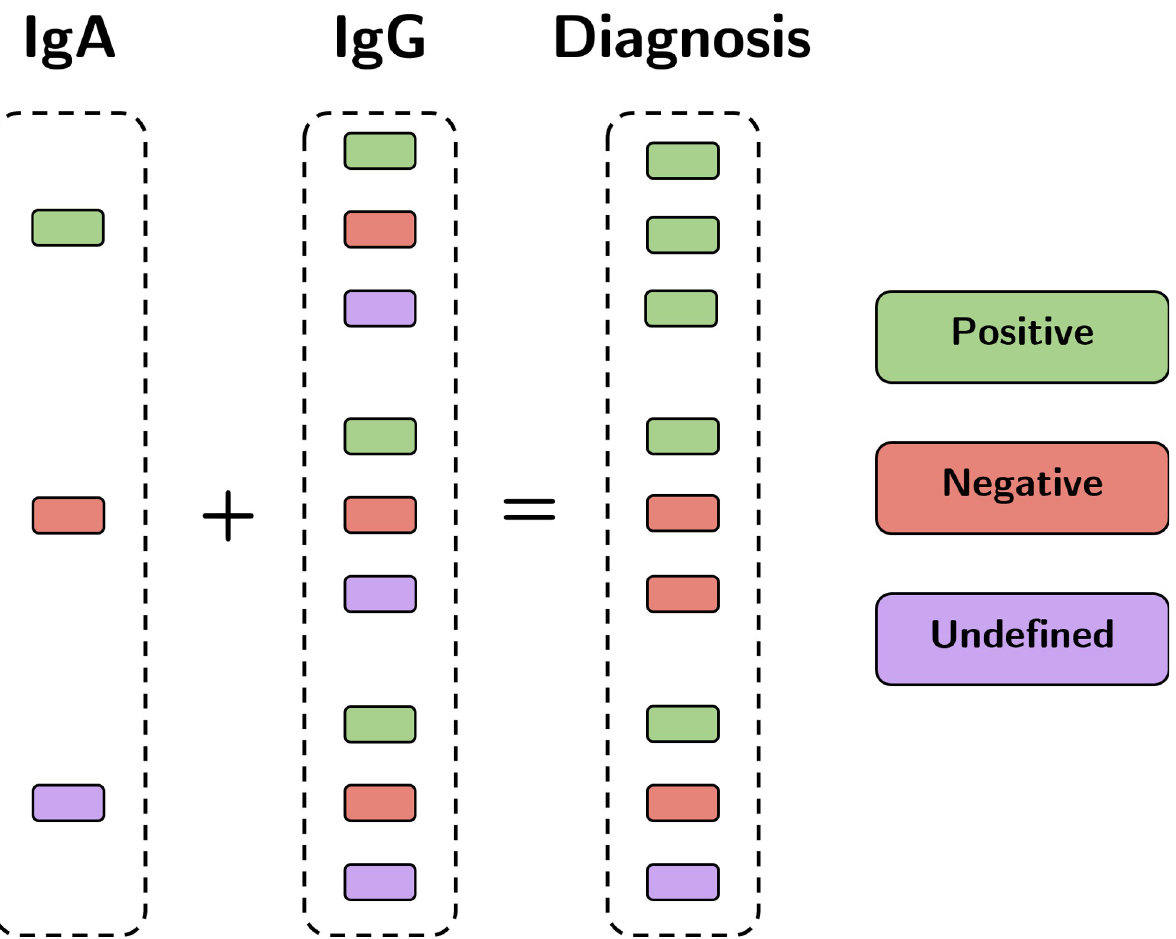
Fig 2. Summarization of all positive combinations of